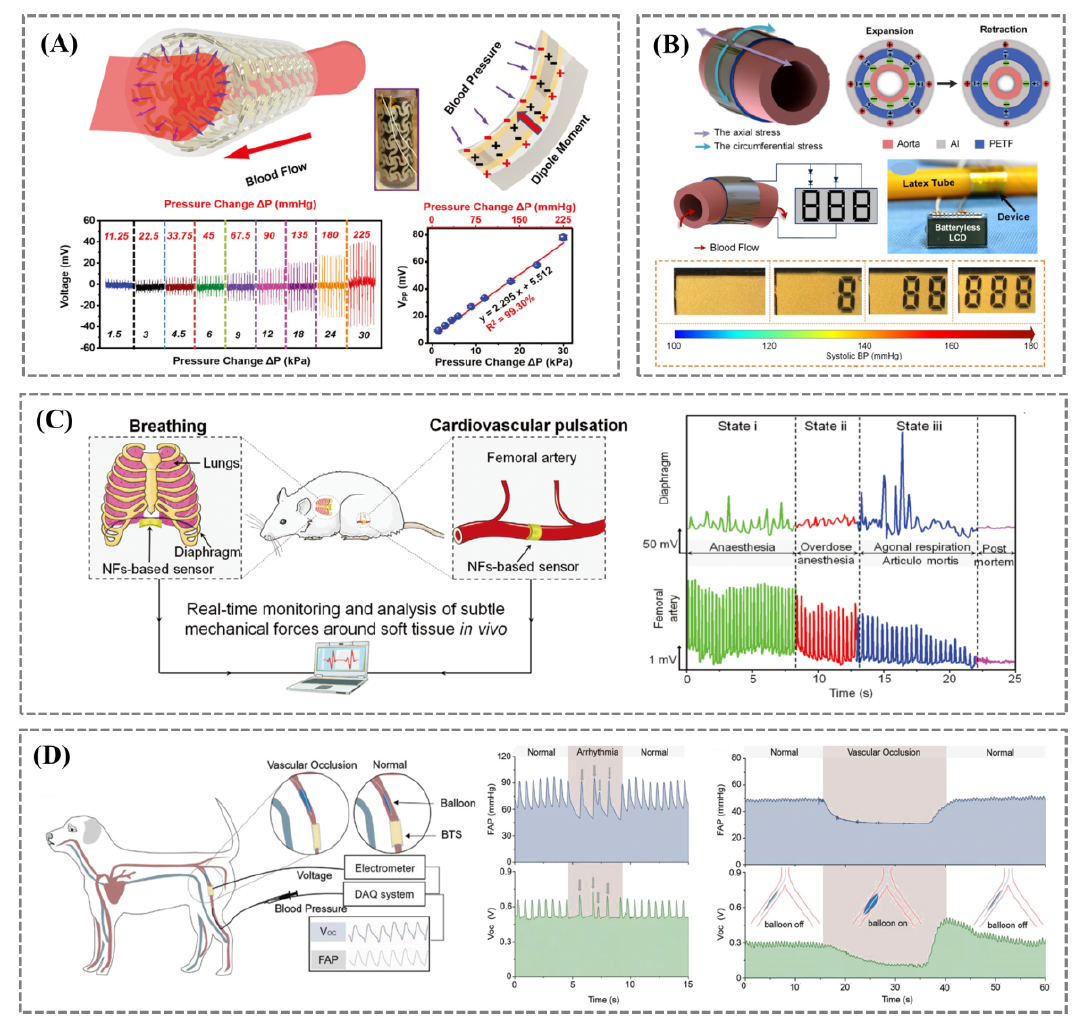
Figure 5. ( A ) Schematic showing the response of the piezoelectric effect to blood pressure in artificial artery. Reprinted/adapted with permission from Ref. [57]. ( B ) An implantable, self-powered, and visualized BP monitoring system. Diagram illustrating the circumferential stress in the expanding aortic wall, inducing the charge distribution of the piezoelectric sensor. Reprinted/adapted with permission from Ref. [61]. ( C ) Diagram of implantable PVDF/DA NF − based sensor for monitoring subtle mechanical pressure changes in vivo. Reprinted/adapted with permission from Ref. [63]. ( D ) Schematic of the bioabsorbable triboelectric sensor (BTS) monitoring physiological signals in vivo. Reprinted/adapted with permission from Ref. [64].